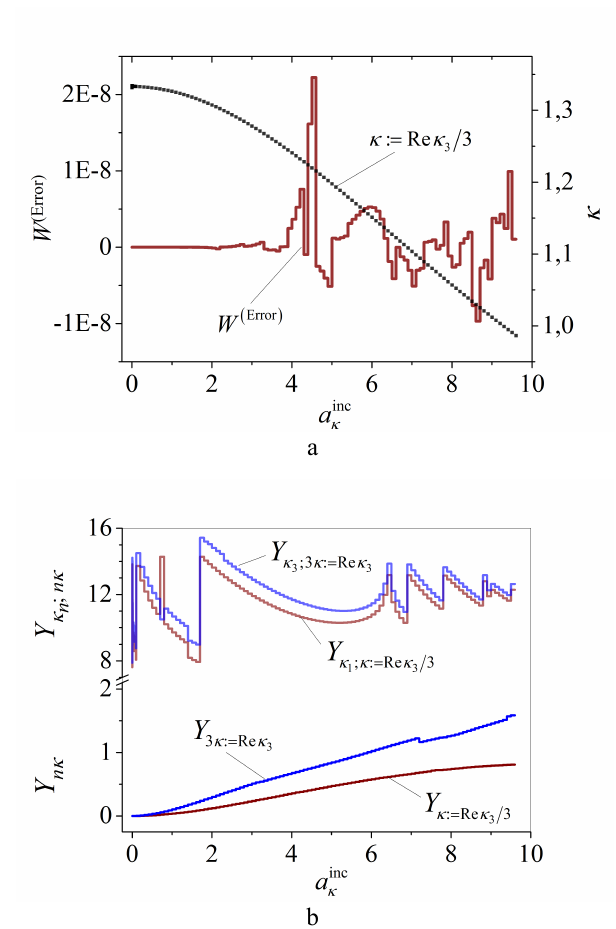
b Figure 8: Behaviour of the self-consistent iterative processes (9) at obtained by means of Weddle's quadrature rule for equation systems of dimension . Curves: (a) the error of the energy balance and frequencies;